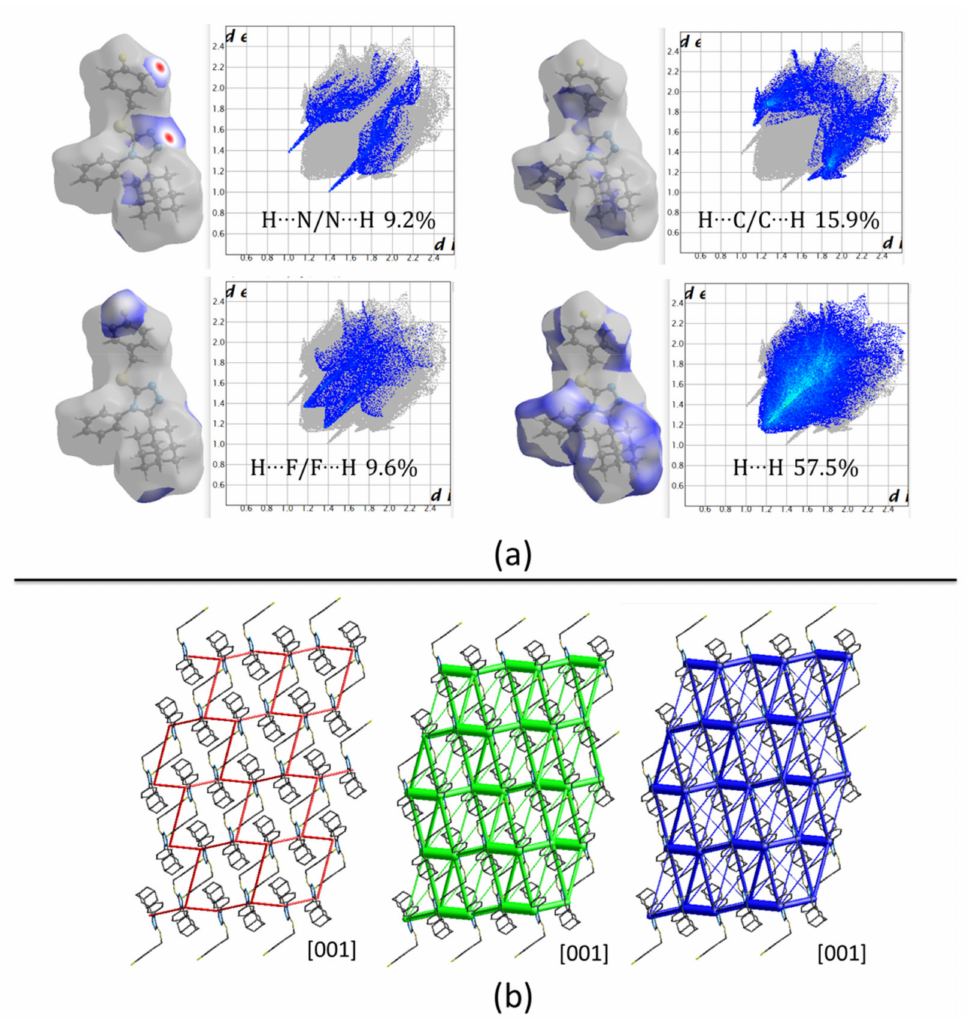
Figure 7. ( a ) Hirshfeld surfaces mapped over d norm and the two-dimensional fingerprint plots, ( b ) Energy framework diagrams for electrostatic (red) and dispersion (green) contributions to the total interaction energies (blue) in compound 2